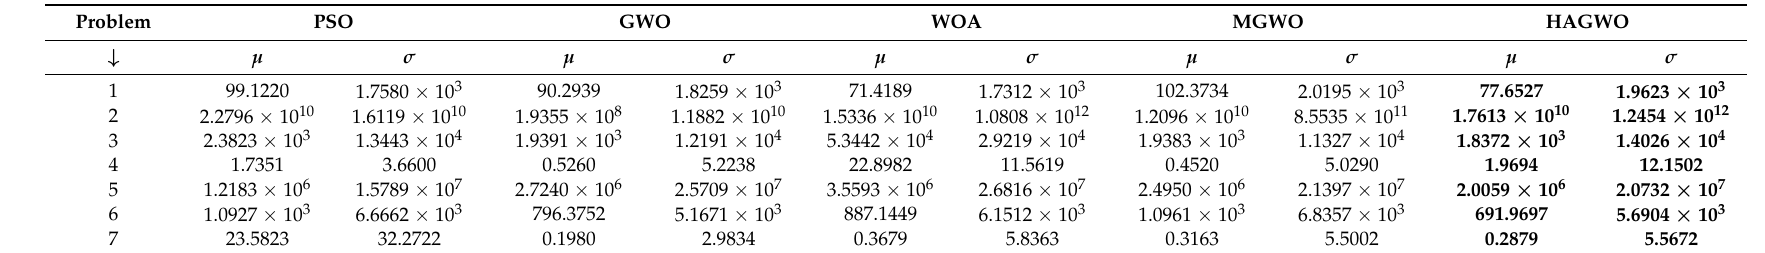
Table 5. Statistical results of unimodal benchmark functions.